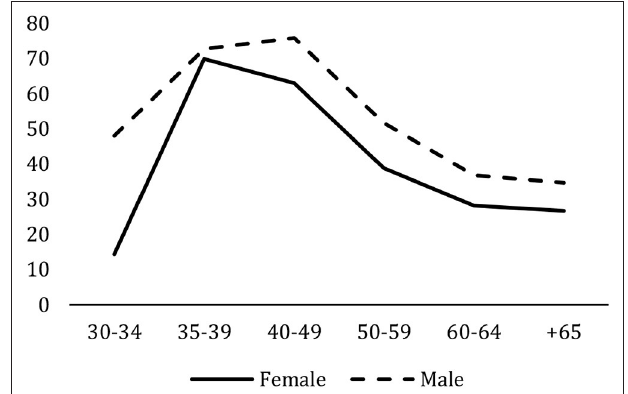
FIGURE 3 | Optimal research sexennials by age and gender. 2019–2020 academic year. Percentage. Integrated University Information System (SIIU).